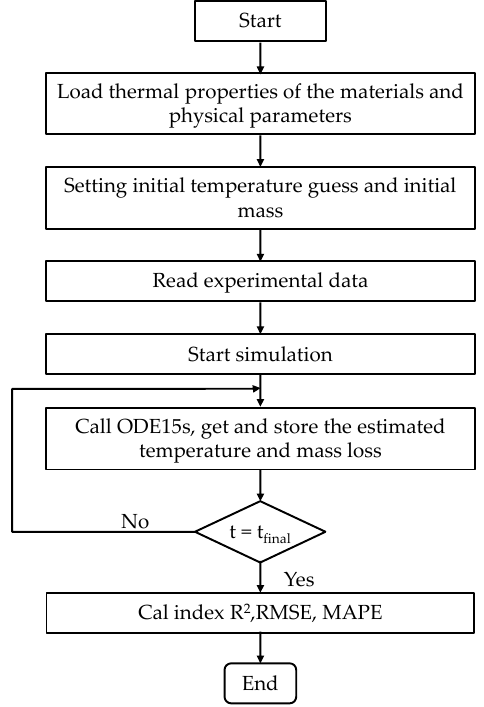
Figure 2. Flow chart of the simulation procedure.